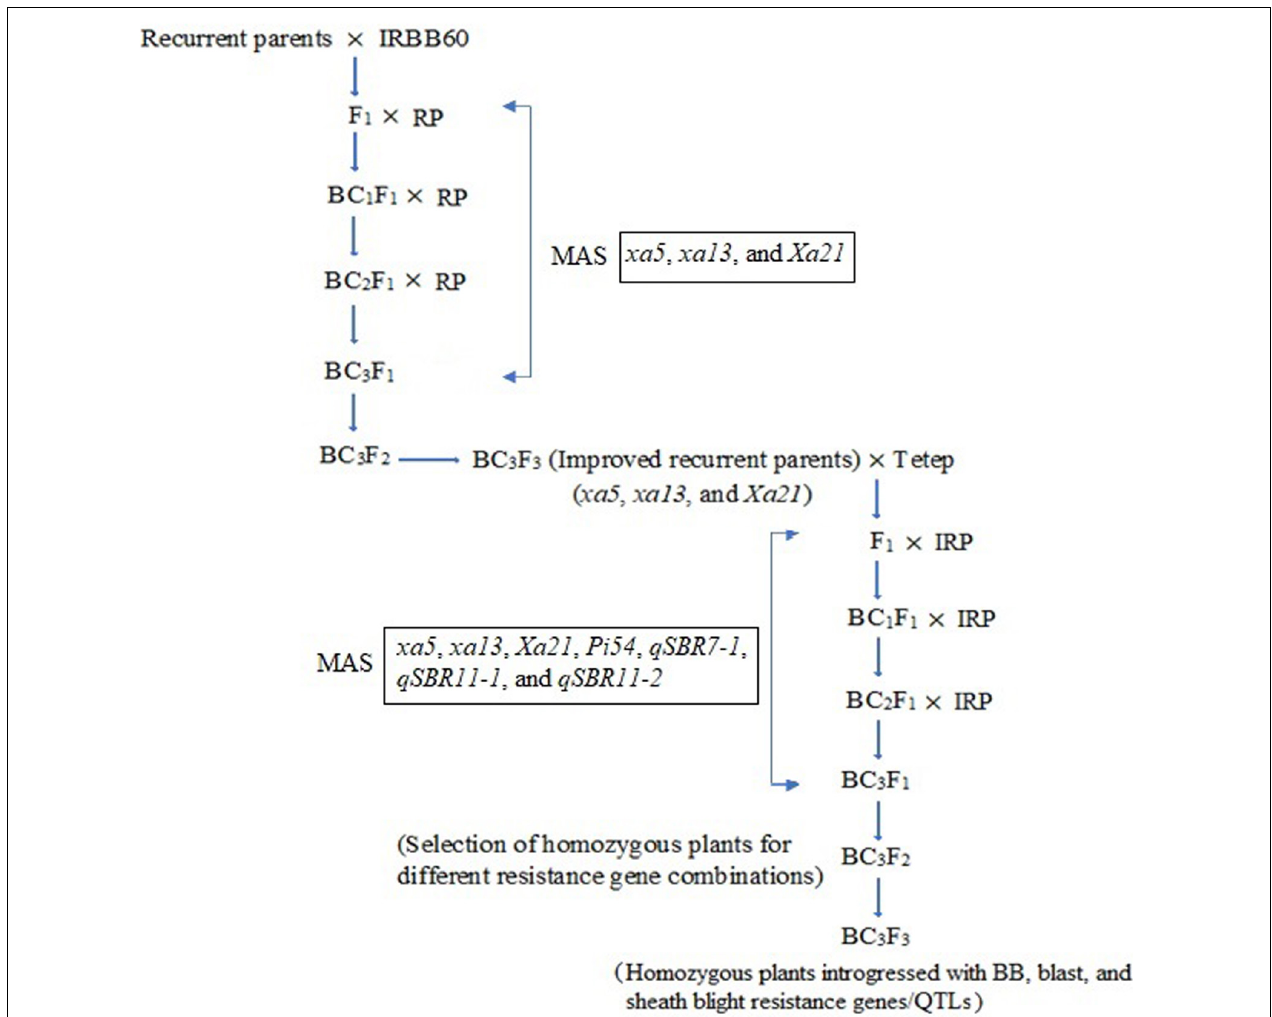
FIGURE 1 | Schematic illustration of marker-assisted gene pyramiding of bacterial blight, blast, and sheath blight resistance genes/QTLs in the backgrounds of ASD 16 and ADT 43. RP, recurrent parents (ASD 16 and ADT 43), IRP, improved recurrent parents (ASD 16 and ADT 43 introgressed with xa5 , xa13 , and Xa21 genes); MAS, marker-assisted